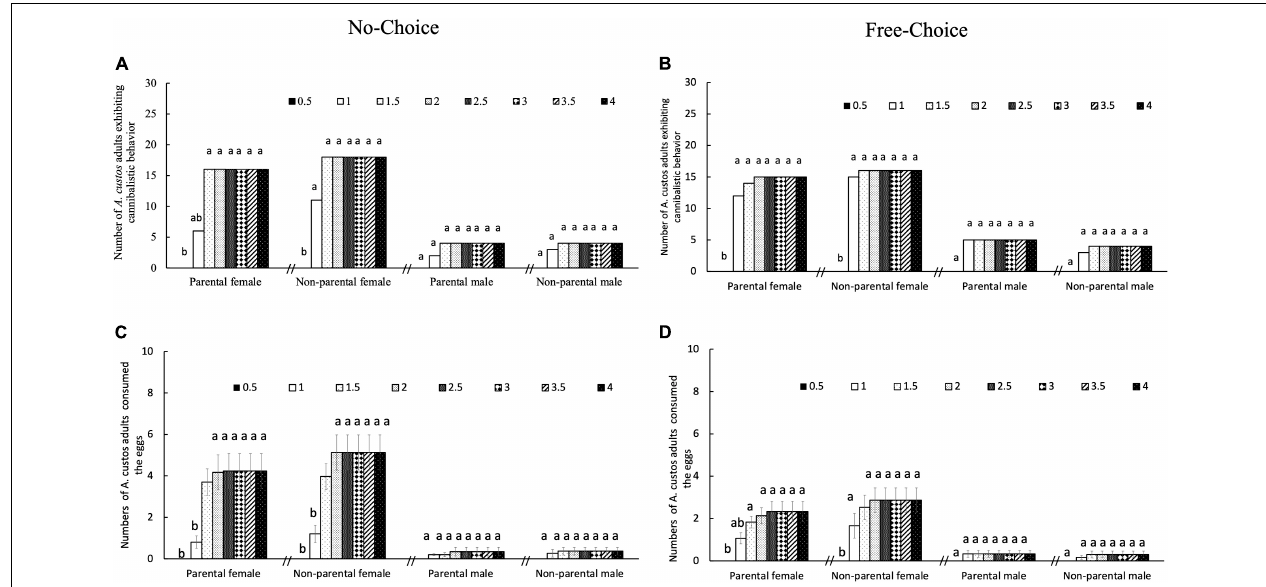
FIGURE 7 | Egg cannibalistic behavior of female and male A. custos adults under no-choice and free-choice conditions at different times for 4 days. Cannibalistic behavior did not change after 4 days of incubation with eggs. Under the no-choice condition, each A. custos adult was incubated with 30 parental or 30 non-parental eggs, whereas under the free-choice condition, each adult was simultaneously incubated with 15 parental and 15 non-parental eggs. A total of 30 replicates were used for each food choice. Different lowercase letters on pillars indicate significant differences ( p < 0.05). A total of 30 replicates were used for each food choice experiment. Numbers of A. custos adults exhibiting cannibalistic behavior in no-choice (A) and free-choice (B) condition. Numbers of A. custos adults consumed the eggs in no-choice (C) and free-choice (D)